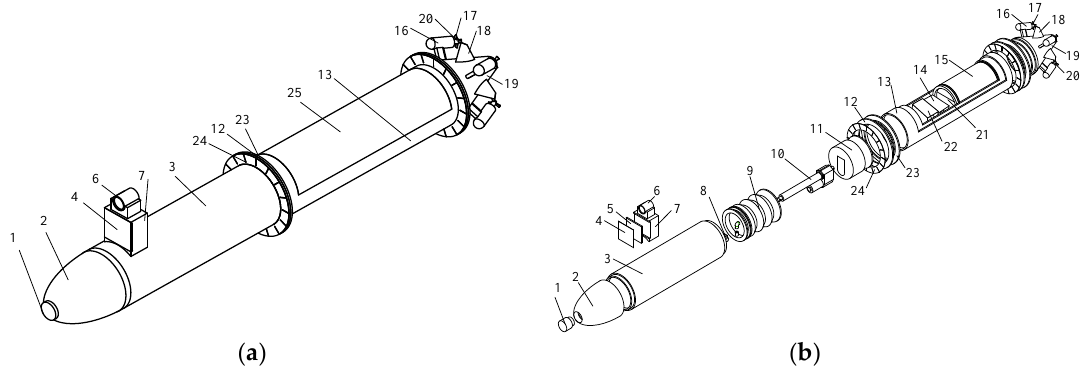
Figure 1. Structure of the proposed unmanned underwater vehicle (UUV). ( a ) Solid model of the UUV; ( b ) exploded drawing of the UUV.